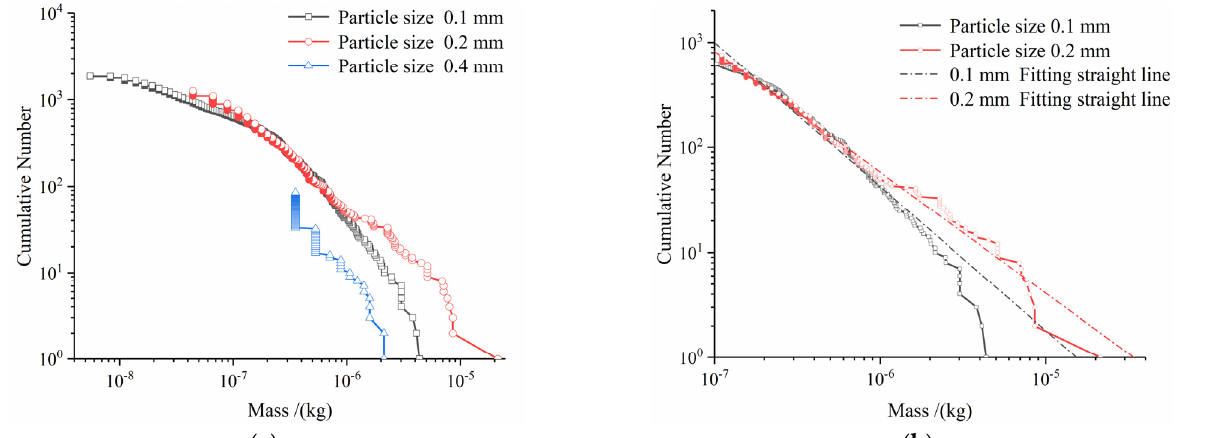
Figure 10. Mass distribution of debris fragments under different particle sizes. ( a ) Mass distribution of debris fragments under three particle sizes; ( b ) mass (>10 − 7 kg) distribution of debris fragments in the case of finer particles.